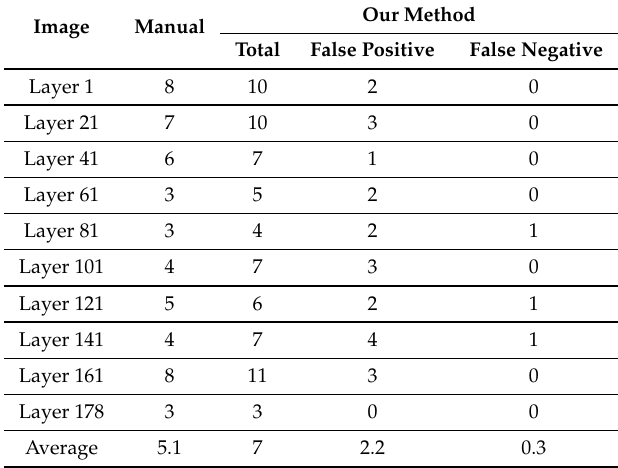
Table 3. The numerical analysis of the identified results of MSBs in 10 images.